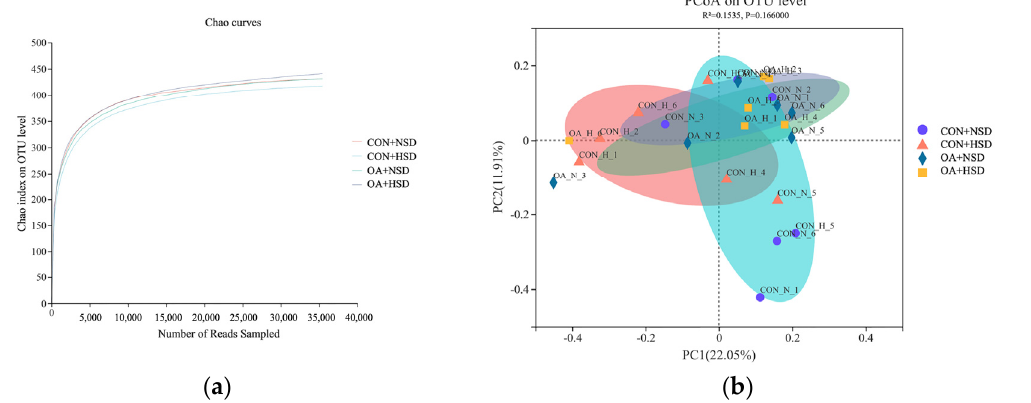
Figure 2. Rarefaction curves ( a ) and effects of organic acids on the beta diversity of cecal bacteria in broilers under high stocking density in the grower phase ( b ). CON+NSD, broilers drank normal water under normal stocking density; CON+HSD, broilers drank normal water under high stocking density; OA+NSD, broilers drank organic acid-supplemented water under normal stocking density; OA+HSD, broilers drank organic acid-supplemented water under high stocking density.